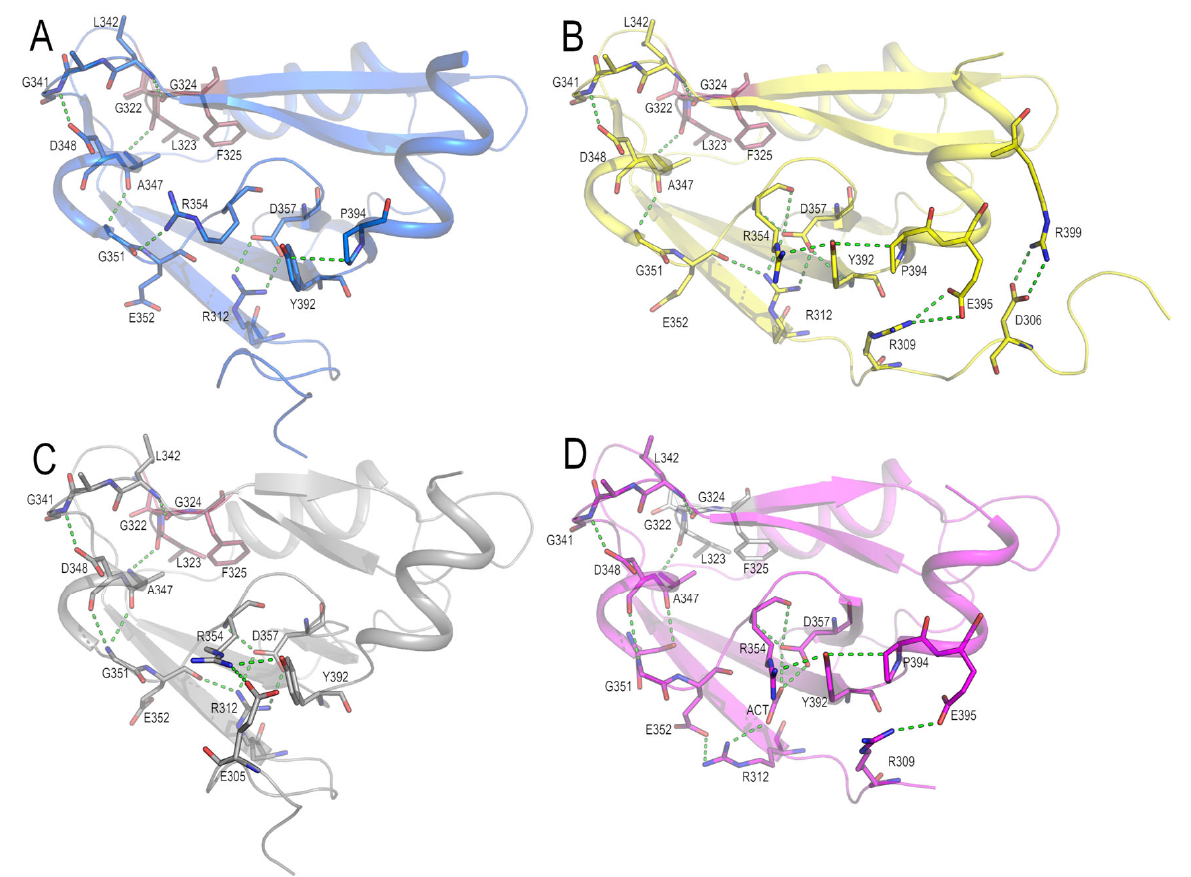
Figure 6. Electrostatic interactions in the ( A ) orthorhomic-A, ( B ) orthorhombic-B, ( C ) monoclinic and, ( D ) trigonal polymorphs. For clarity, only one chain of the monoclinic and trigonal polymorphs is shown. Residues at hydrogen bond distance are shown as sticks, and the distances have been represented with green dashed lines. Residues belonging to the canonical binding site, GLGF, have been coloured differently.